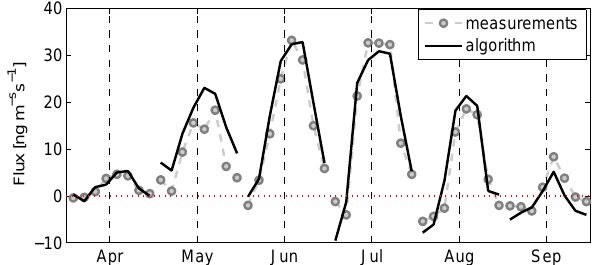
Figure 10. Diurnal cycles (hourly medians) of methanol fluxes from April until October (years 2010–2013). The measurements were performed at 0200, 0500, 0800, 1100, 1400, 1700, 2000, and 2300 UTC+2, and the dashed lines represent noon